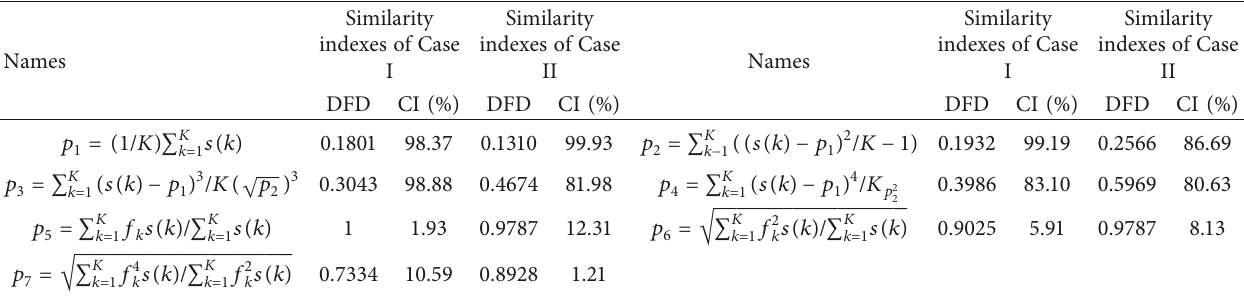
Figure 9: The shape factor, crest factor, impulse factor, and clearance factor of the whole life of (a) Case I and (b) Case II. Table 3: The frequency domain features and their similarity indexes of Case I and Case II based on